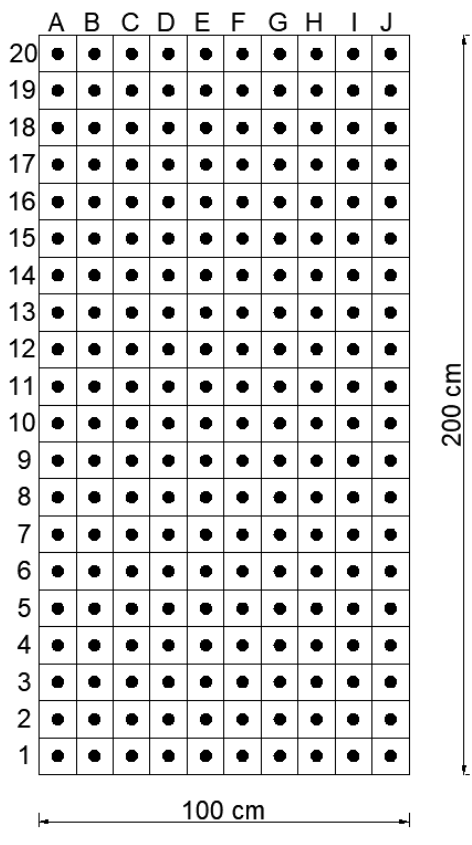
Figure 7. Layout of the test area.